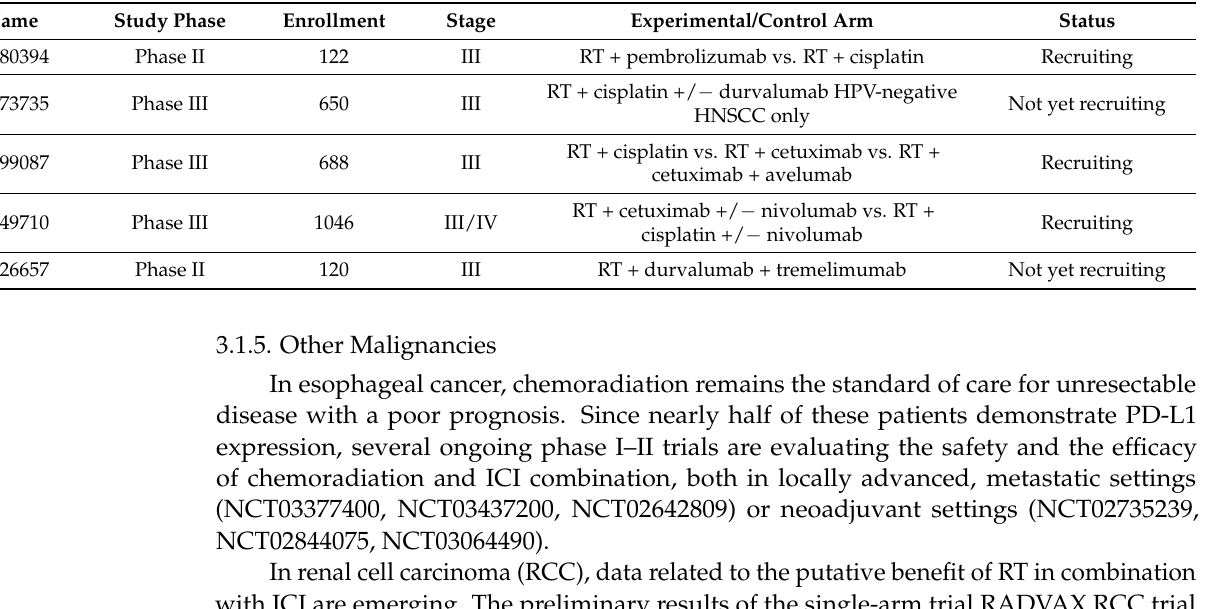
Table 3. Main ongoing clinical trials with ICI/RT combinations in advanced